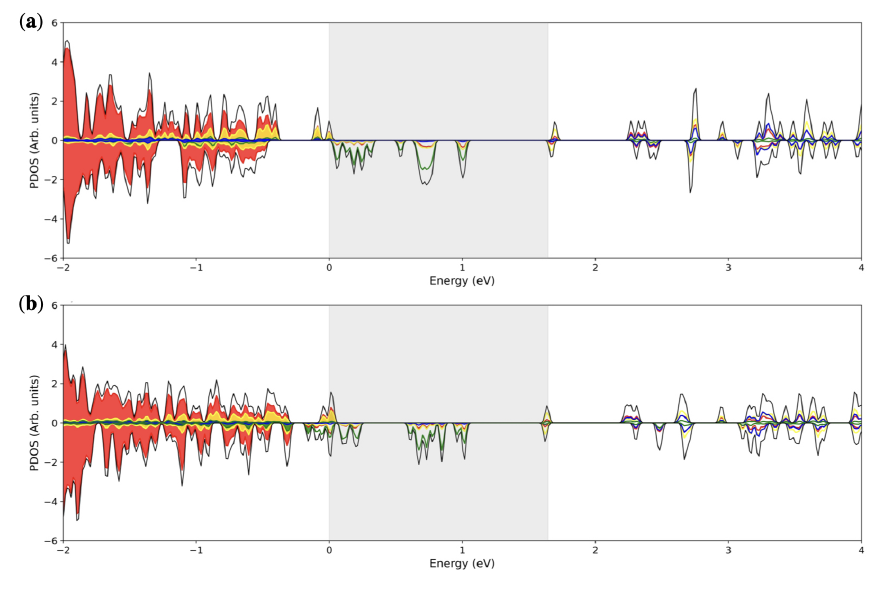
Figure 8. PDOS for ( a ) α 4 and ( b ) β 4 systems (i.e., p = 0.25) (copper = red, sulfur = yellow, aluminium = blue and iron =